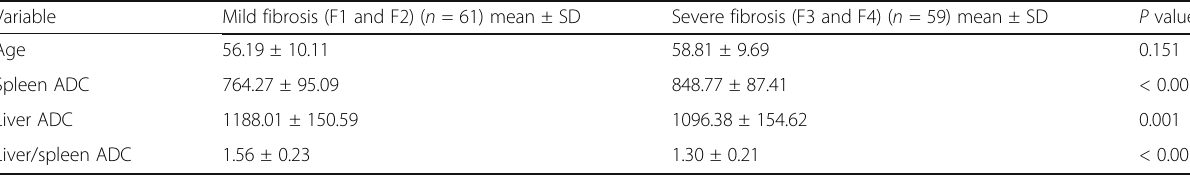
Table 4 Age and different ADC measurements between cases with mild fibrosis and severe fibrosis